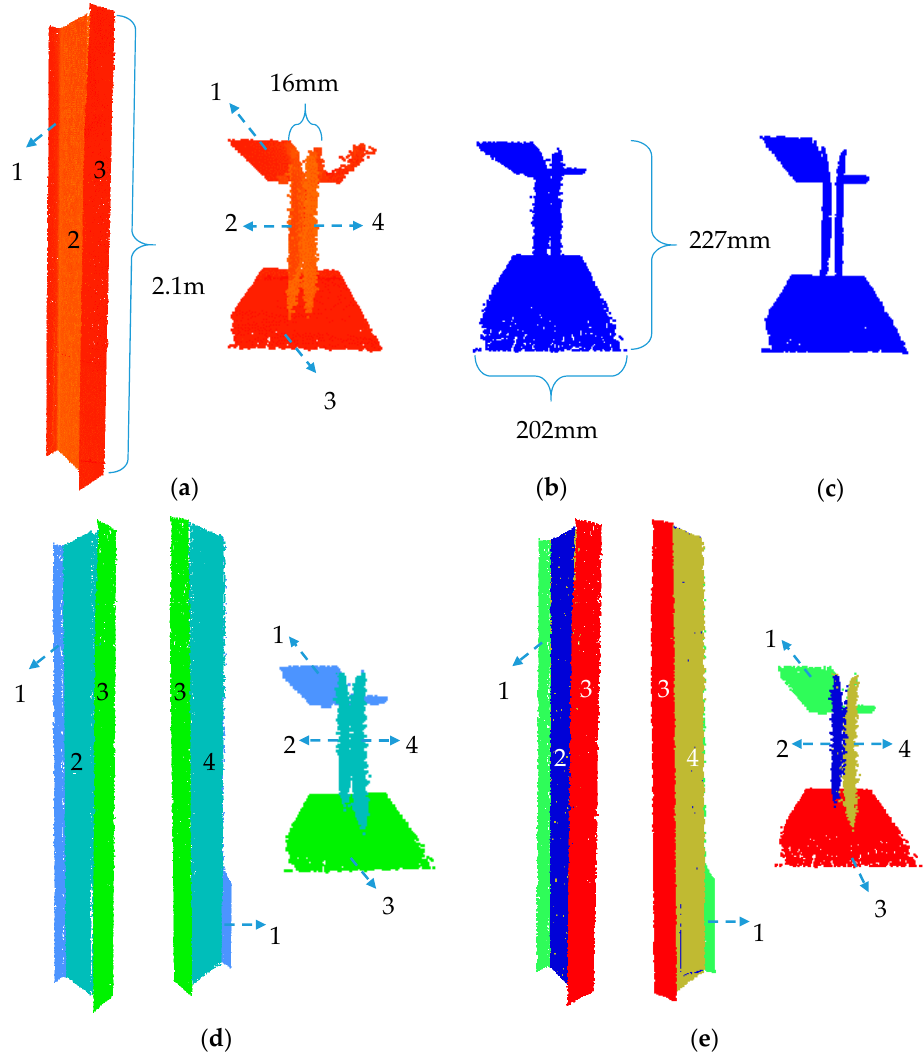
Figure 16. ( a ) Point cloud of a sample H-section column; ( b ) points classified as planar using robust PCA; ( c ) the robust centres of the planar classified points; ( d ) planar segmentation results using [47] method; and ( e ) planar segmentation results using our proposed method.